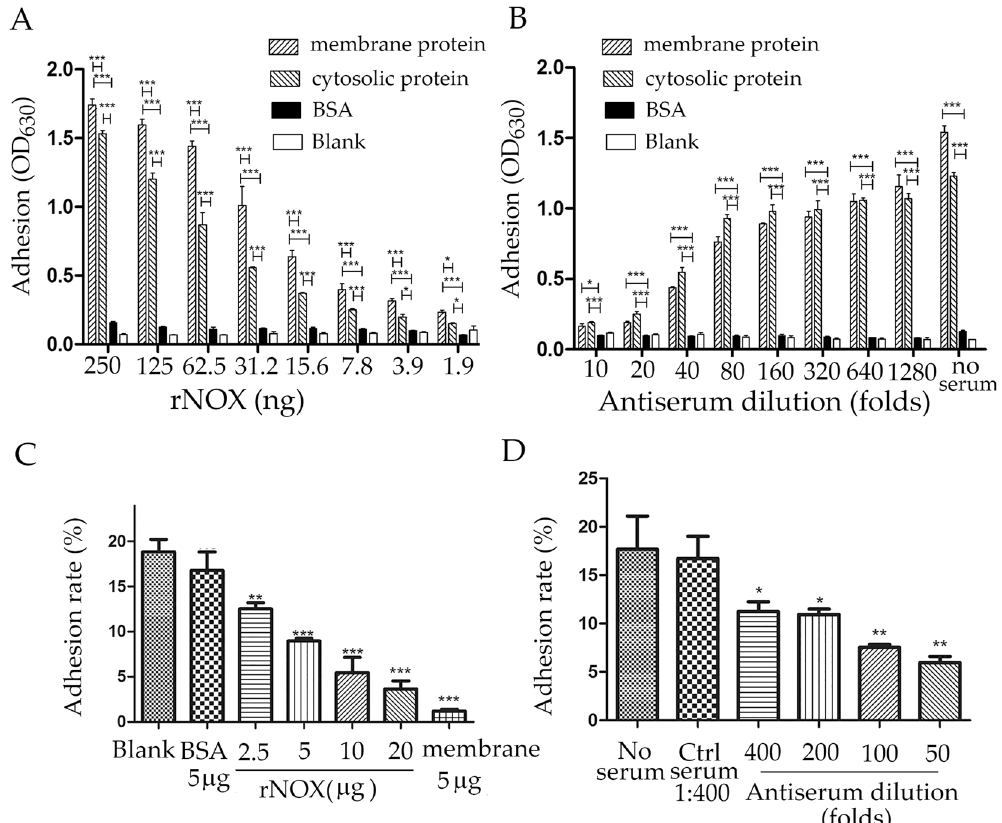
Figure 4. rNOX adhesion and adhesive inhibition assays with ELISA and flow cytometry. ( A ) Adhesion of rNOX to EBL cells detected by ELISA. 0.5 μ g rNOX in 100 μ l PBST containing 5% BSA was serially diluted to 128-folds and 100 μ l of each dilution was added into the coated wells and incubated in the plates. ( B ) Adhesive inhibition of rNOX to EBL cells detected by ELISA. The adhesion of 0.25 μ g rNOX was inhibited by serial dilutions (from 1:10 to 1:1280) of antiserum to rNOX, and the equal amount of rNOX treatment without antiserum served as control. The wells coated with BSA (0.5 μ g/well) as the negative control or non-coated well as blank control. ( C ) The adhesion of M. bovis to EBL cells inhibited by rNOX. The 10 6 EBL cells were incubated with different concentration of rNOX before infection. BSA (5 μ g) in 1 ml of MEM, 5 μ g of M. bovis membrane proteins in 1 ml of MEM, and 1 ml of MEM alone were used as the negative, positive, and blank controls, respectively. ( D ) The adhesion of M. bovis to EBL cells inhibited by anti-rNOX serum. M. bovis were incubated with anti-rNOX serum diluted from 1:50 to 1:400 before infection. The mixed negative serum (three unimmunized mice serum) was severed as negative control and 1 ml of MEM without serum (No serum) was used as the blank control. * p < 0.05, ** p < 0.01, *** p < 0.001 represent statistically significant difference, and very significant difference, while “ns” represents no